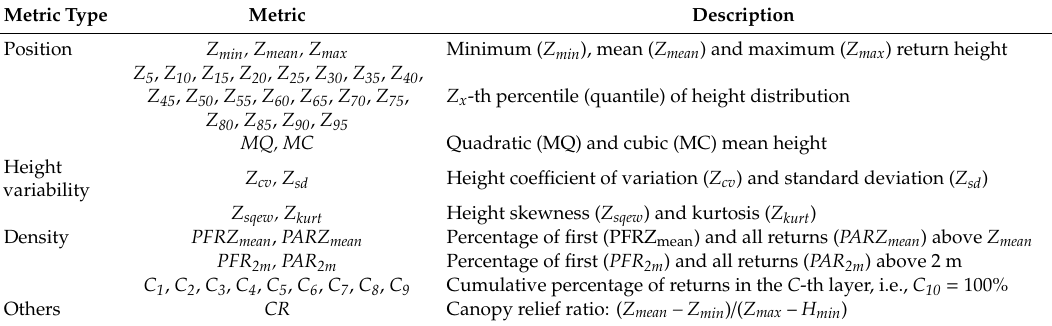
Table 3. Description of candidate metrics derived from airborne laser scanning